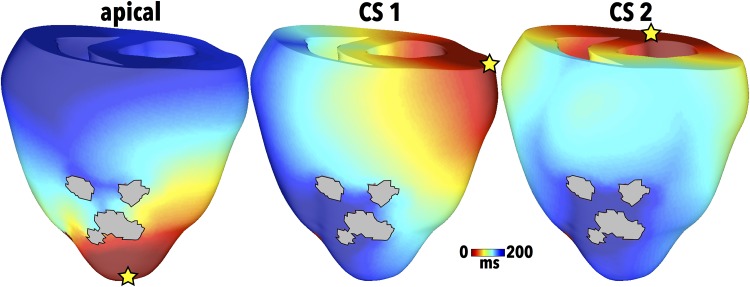
Pacing locations in the rabbit ventricular model (for the LAD scar anatomy) signified by yellow stars with corresponding S1 AT maps for apical (left), CS1 (centre) and CS2 (right) sites.